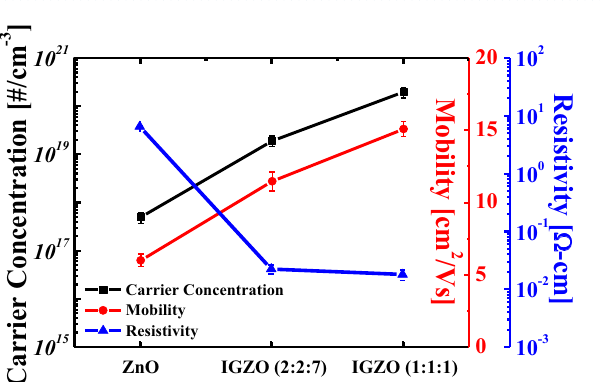
Figure 3. Atomic force microscopy topography images of single ( a ) IGZO (1:1:1), ( b ) IGZO (2:2:7), and ( c ) ZnO films, and ( d ) a single IGZO memristor(IGZO(2:2:7)/IGZO(1:1:1)) and ( e ) a bi-layer IGZO/ZnO memristor. ZnO film can be observed by small grains of nanometric dimension.